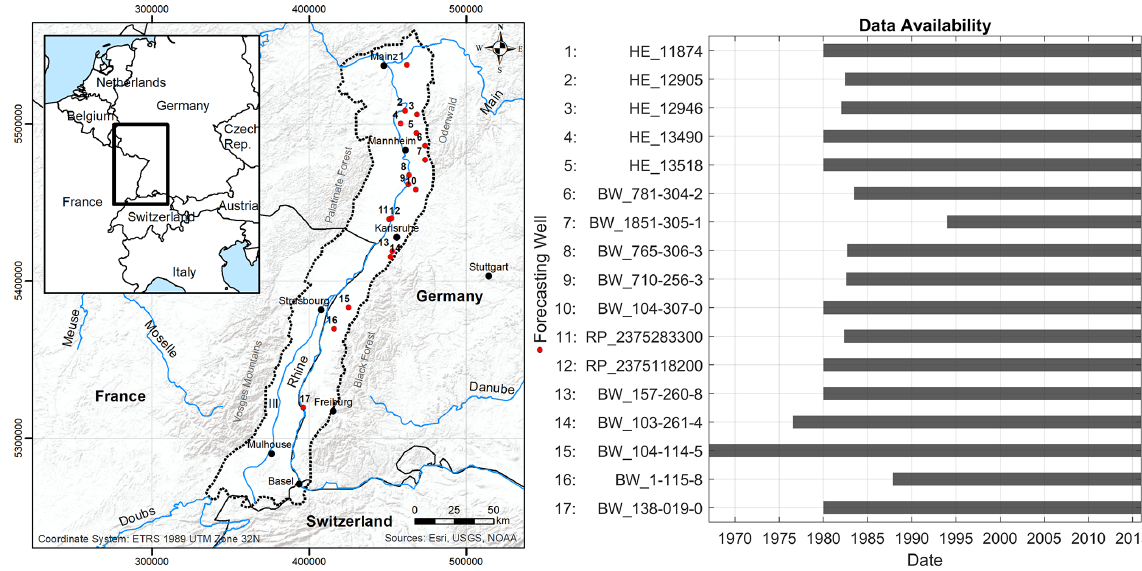
Figure 3. Study area and positions of examined wells (left), as well as respective time series length for each of the wells (right).